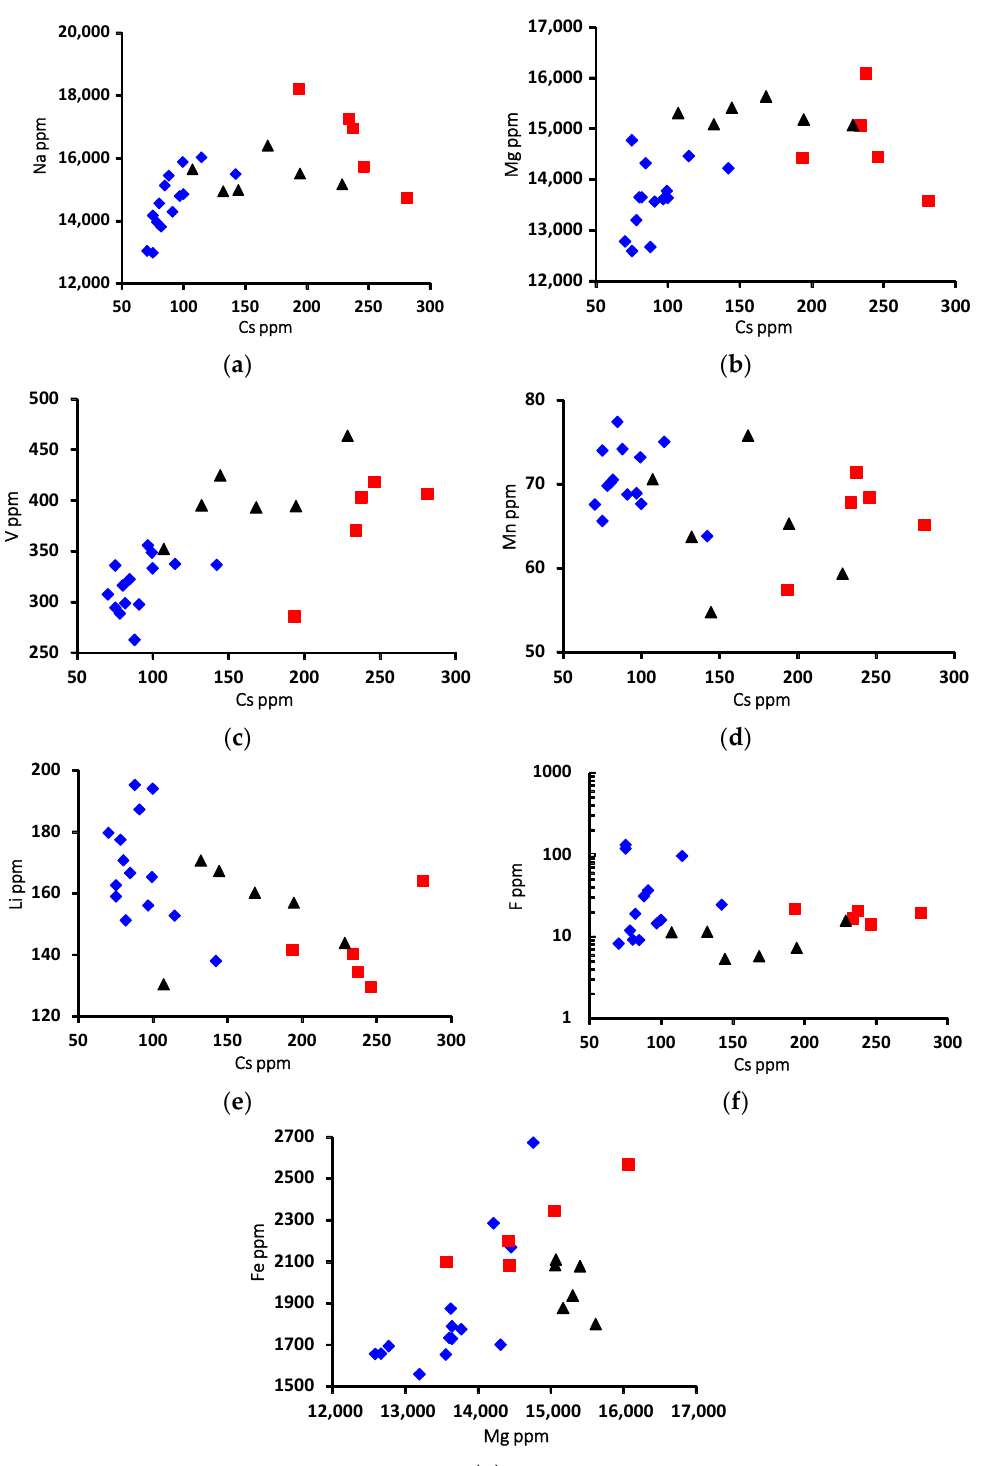
Figure 5. Binary diagrams show the correlation of trace and minor elements (ppm) in beryl from Wadi Nugrus, South Eastern Desert, Egypt. Symbols are the same as in all of the following diagrams: red square for bright-green rim (spots 1–5), black triangle for pale-green rim (spots 20–25) and blue lozenge for brown-green core (spots 6–19) of beryl crystal. ( a ) Na–Cs; ( b ) Mg–Cs; ( c ) V–Cs; ( d ) Mn–Cs; ( e ) Li–Cs; ( f ) F–Cs; ( g ) Fe–Mg binary diagrams.